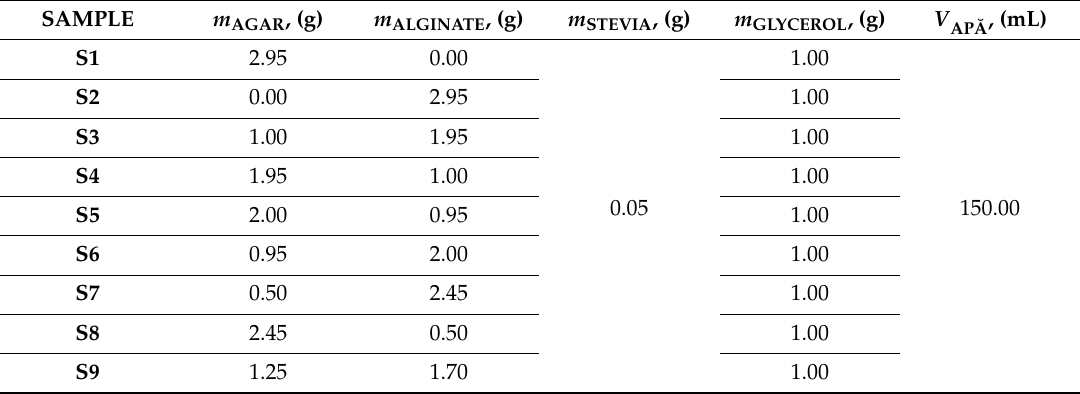
Table 1. Ingredients and related quantities used to obtain